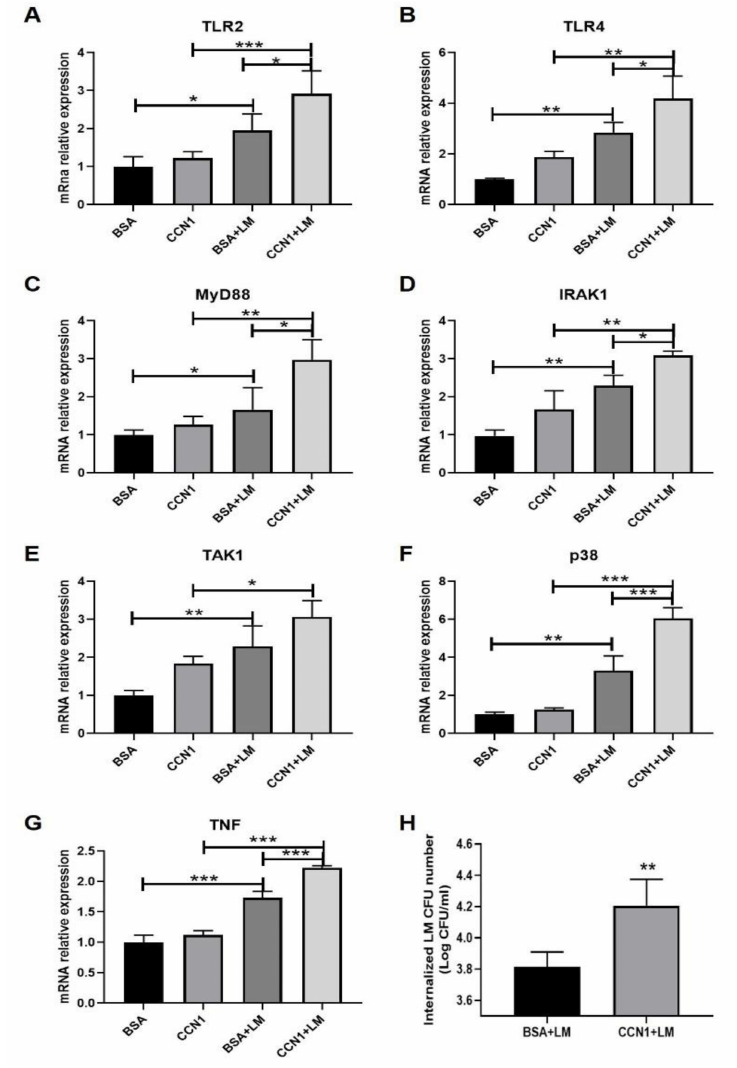
Figure 7. The changes in TLR2/4 signaling pathways in response to L. monocytogenes infection in organoids pre-treated with CCN1 protein. ( A – G ) mRNA levels of TLR2 , TLR4 , MyD88 , IRAK1 , TAK1 and p38 from organoids samples. ( H ) The number of L. monocytogenes in the organoids. * p < 0.05, ** p < 0.01, *** p <